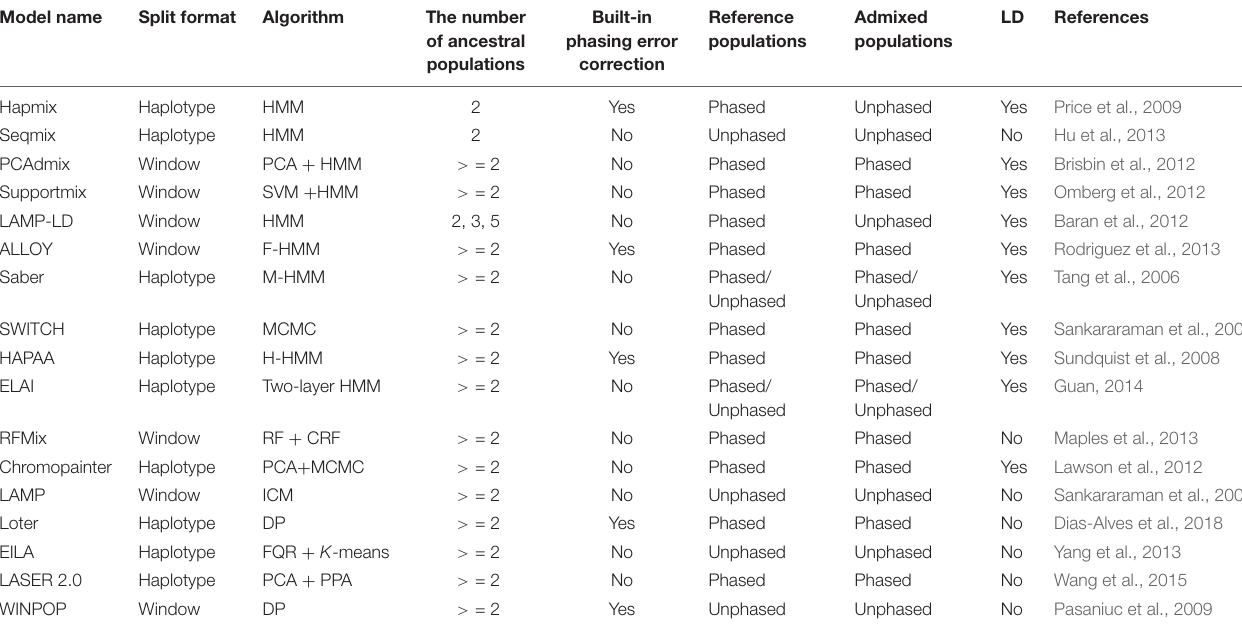
TABLE 1 | Detailed deconvolution model